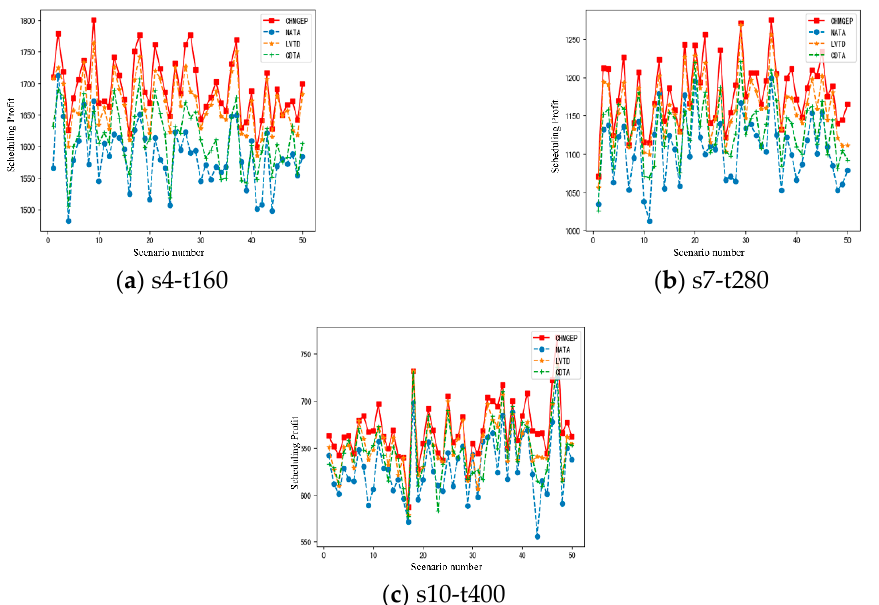
Figure 10. The comparison of heuristic algorithms in different scenarios. ( a ) The scenario of s4-t160; ( b ) The scenario of s7-t280; ( c ) The scenario of s10-t400;